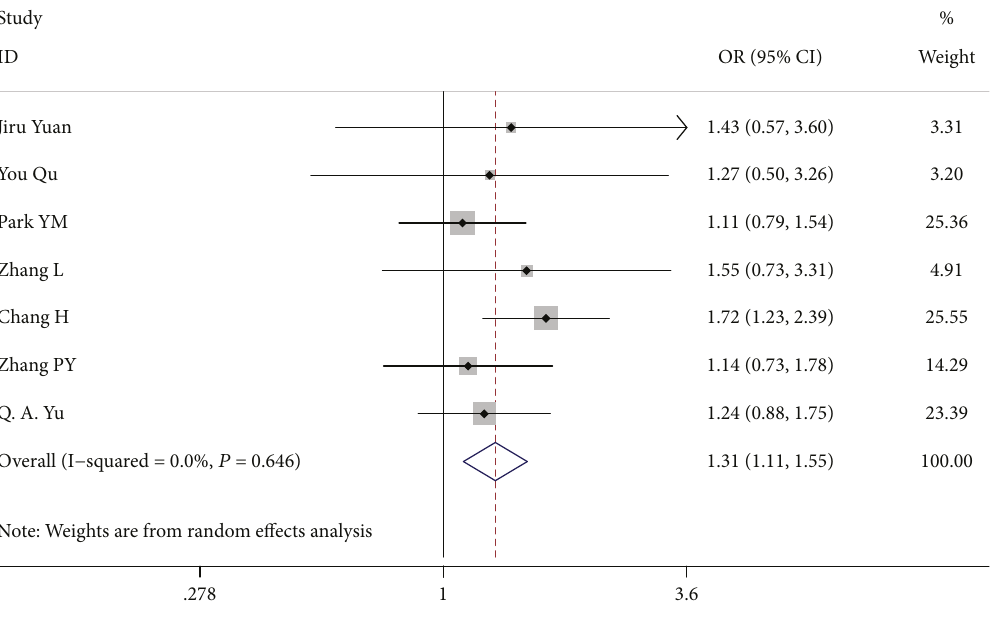
Figure 2: Forest plot for metastasis according to age.